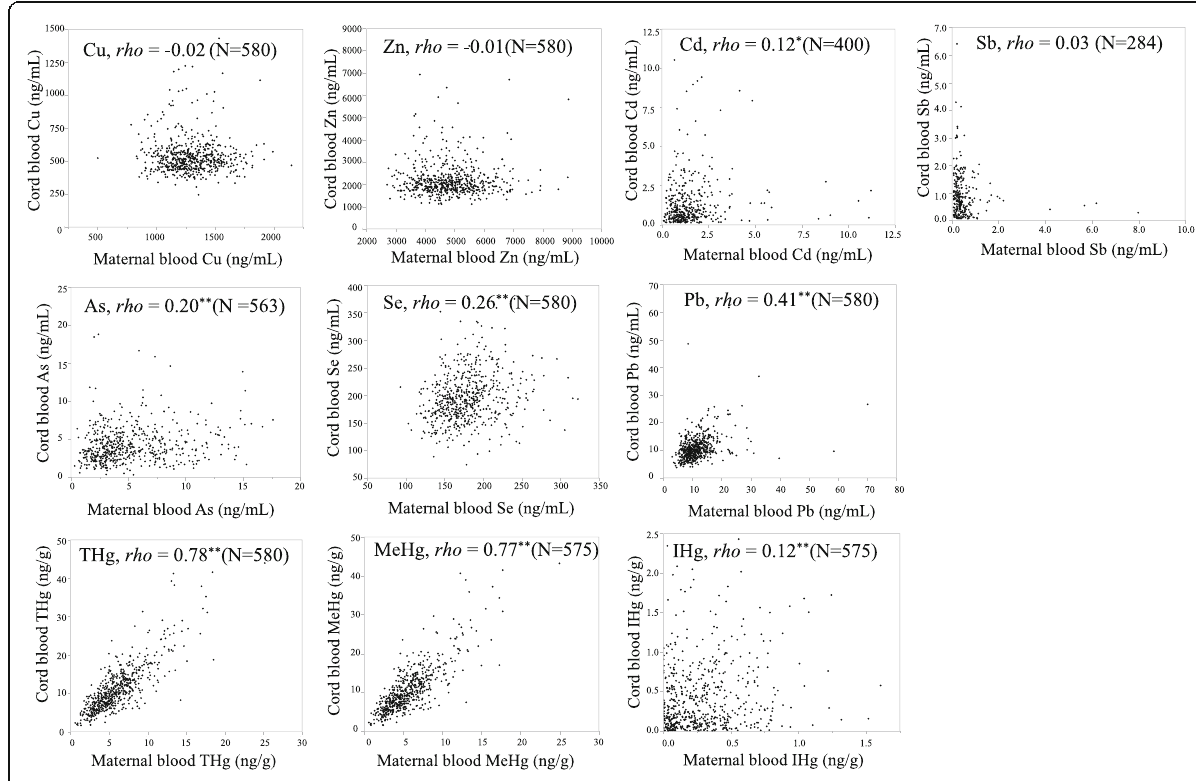
Fig. 1 The relationships between the same element in the maternal blood and those in cord blood. Spearman ’ s rank correlation coefficients ( rho ), ** P < 0.01, * P < 0.05. Values less than the LODs were